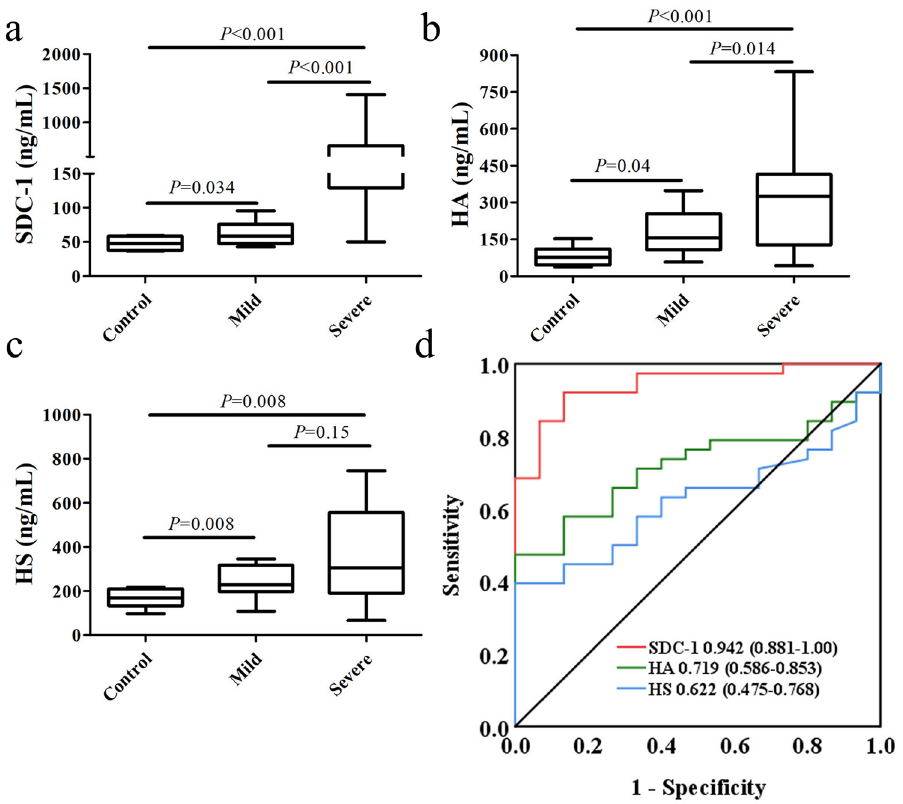
Figure 2. Plasma levels of glycocalyx components and ROC curves for the prediction of severe influenza A (H1N1). Plasma SDC-1 ( a ), HA ( b ), and HS ( c ) levels were significantly elevated in septic shock patients compared with those in sepsis patients. ROC curves ( d ) for the prediction of septic shock. AUC (95% confidence interval). The red rulers in figures A and B represent the median with range. The red rulers in figure C represent the mean with SD. Three-group comparisons of frequencies were analyzed by Kruskal – Wallis test. SDC-1, syndecan-1; HS, heparan sulfate; HA, hyaluronan.